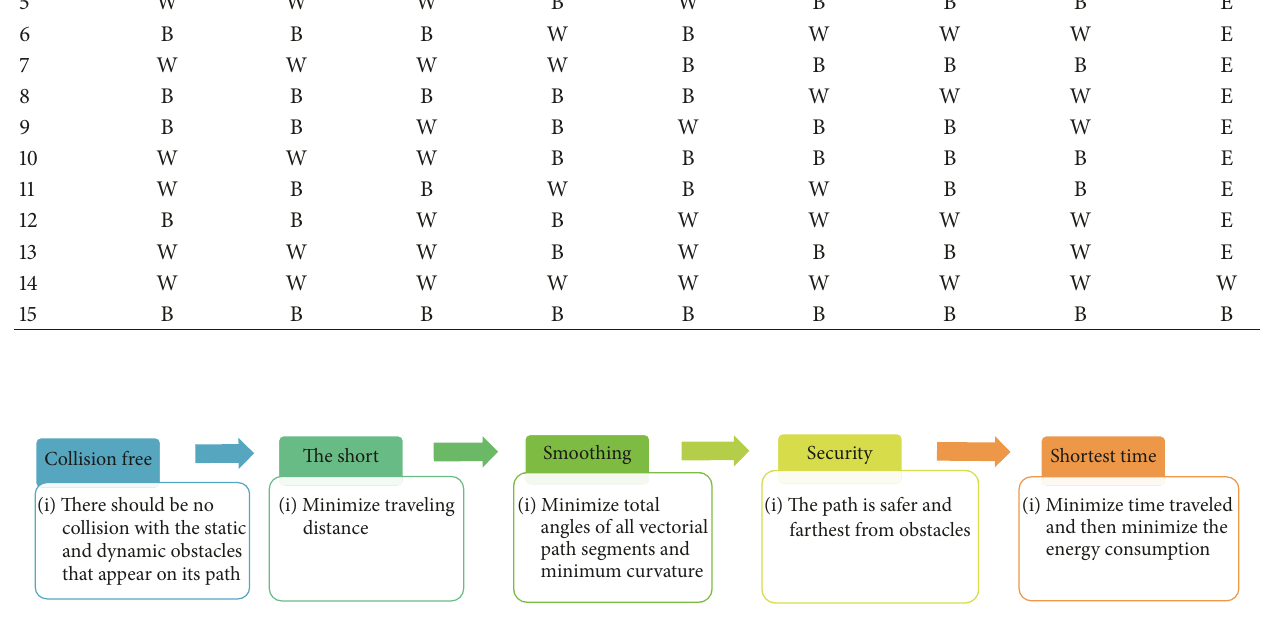
Figure 11: Multiobjectives for trajectory path